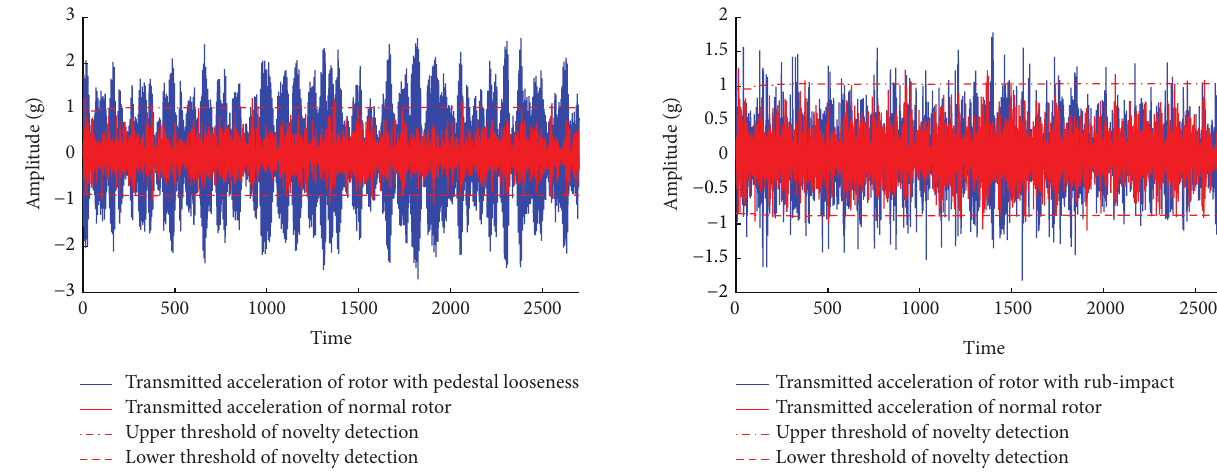
Figure 5: Upper/lower thresholds and acceleration time serials of normal/pedestal looseness rotor.